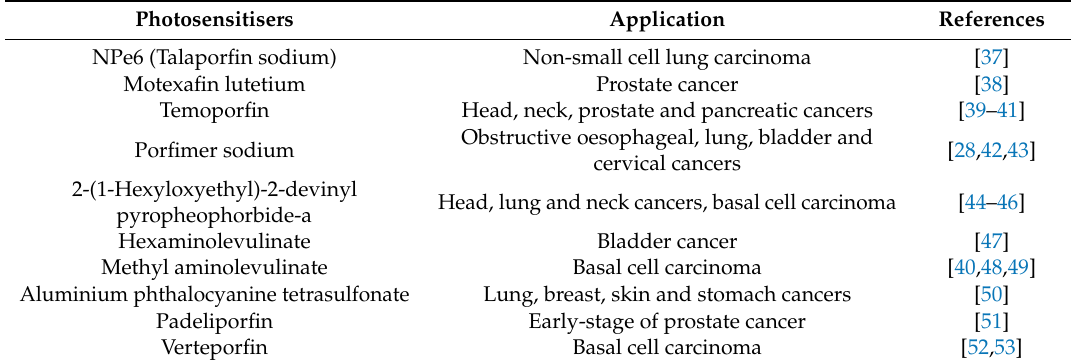
Table 1. Application of clinically approved photosensitisers for treatment of